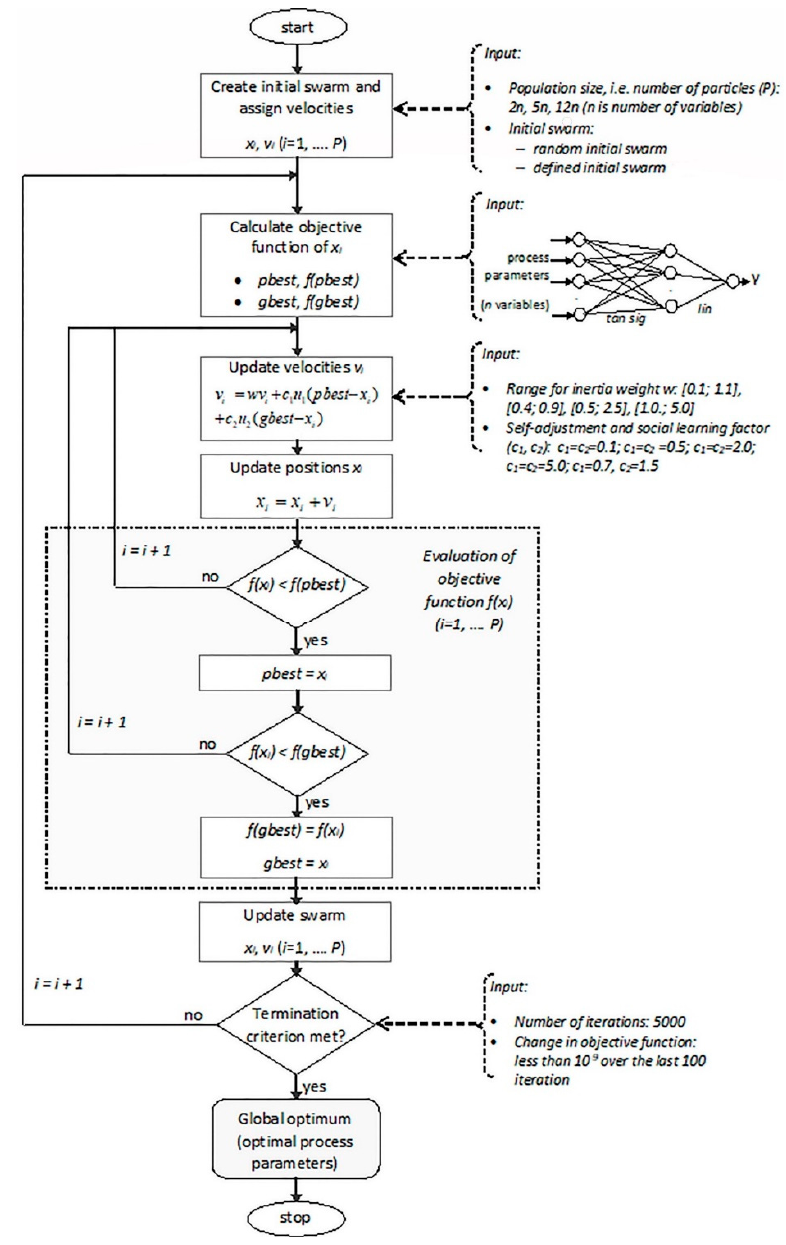
Figure 3. The PSO algorithm flowchart used in this study.